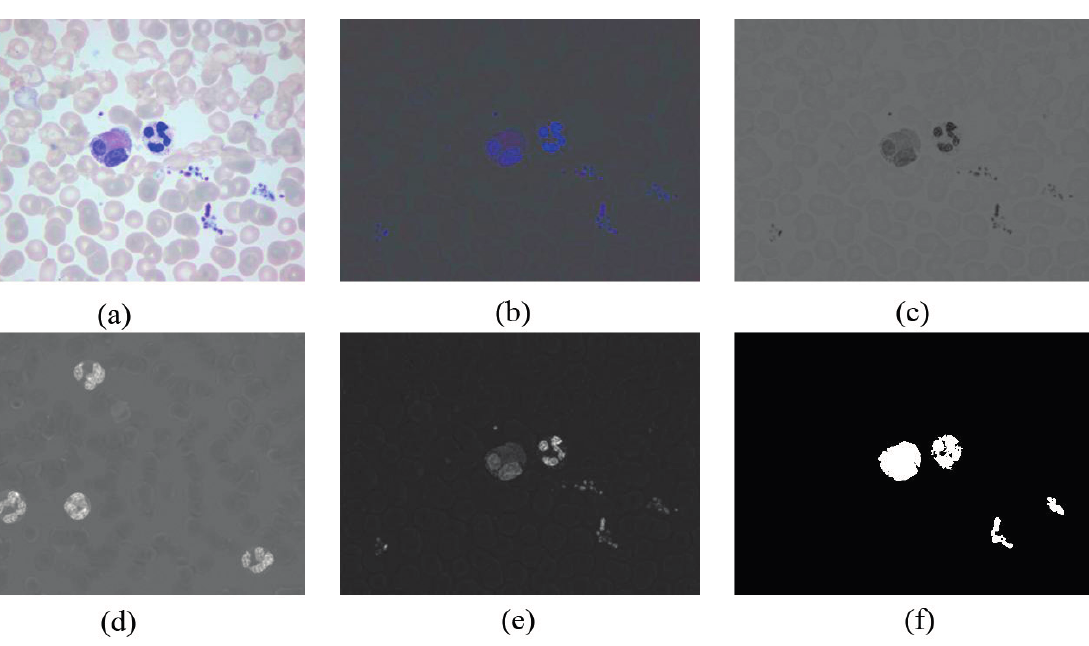
Figure 11. ( a ) Original RGB image in peripheral blood smear; ( b ) Rg chroma